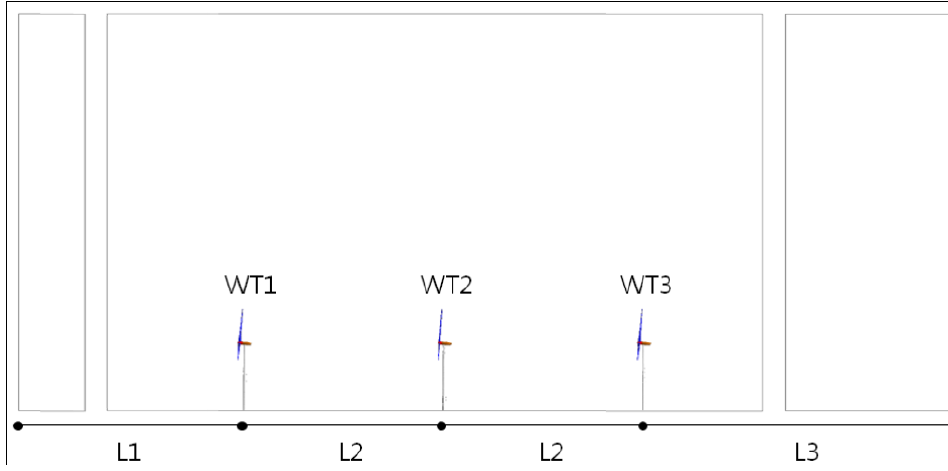
Figure 2. 6 MW offshore wind farm layout and wind turbine